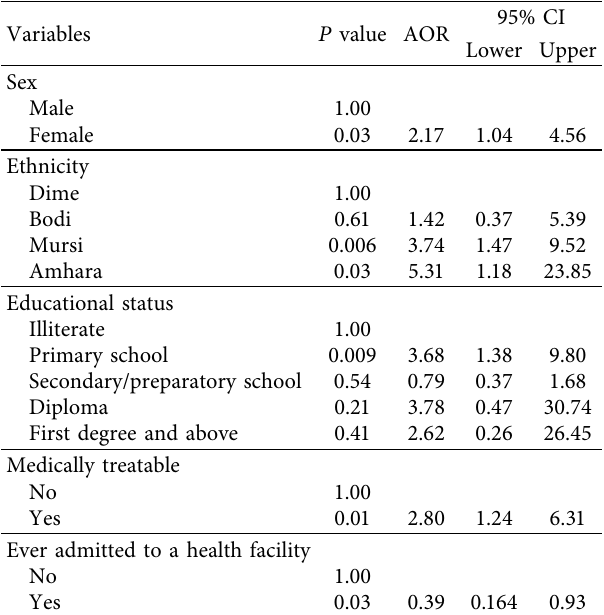
Table 3: Distribution of factors associated with attitude related to Onchocerciasis in Selamago in